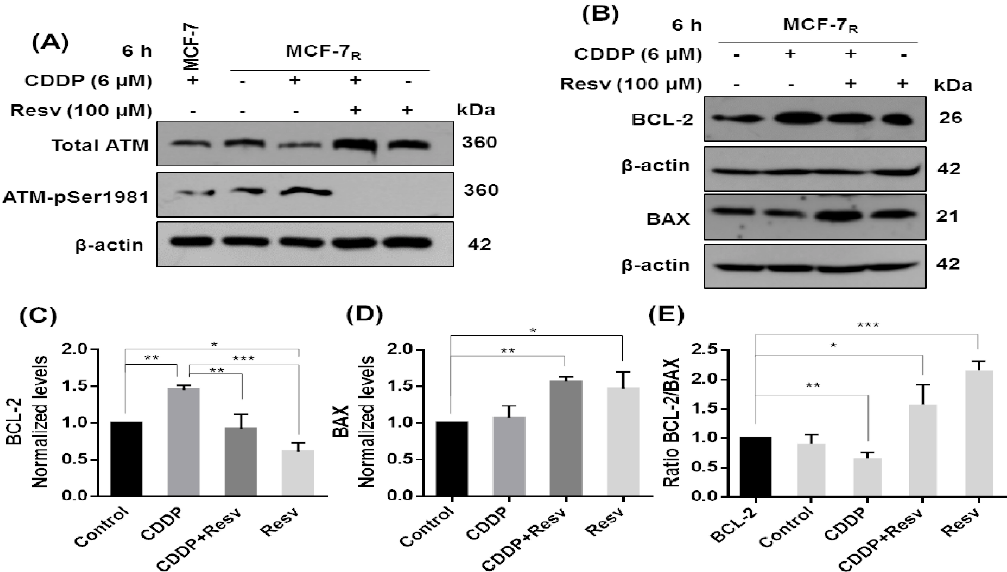
Figure 7. Resv promotes early dephosphorylation of ATM, inhibition of BCL-2, and upregulation of BAX. MCF-7 R cells were treated with CDDP (6 μ M) with or without Resv (100 μ M) for 6 h. ( A ) Total and phospho-ATM and ( B ) BCL-2 and BAX proteins were assessed by Western blot using antibodies directed against total ATM, a specific phosphorylated residue on S1981 of ATM, BCL-2, or BAX. MCF-7 cells with CDPP were used as positive control of ATM phosphorylation. ( C ) Densitometric analysis of BCL-2 and ( D ) BAX after β -actin normalization. ( E ) Ratio between BCL-2/BAX by t test. All results are presented as mean of three independent experiments ± SD. * p < 0.05; ** p < 0.01; *** p < 0.001 by one-way ANOVA followed by Turkey’s or Dunnett’s Multiple Comparison test.